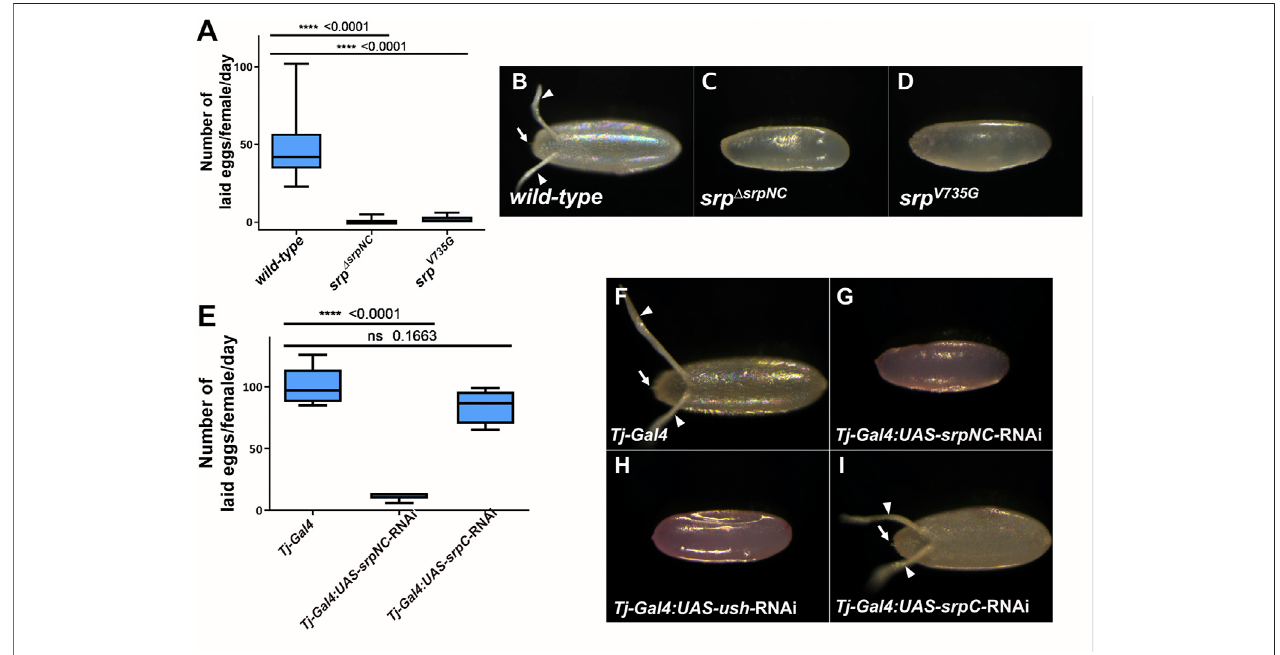
FIGURE6| SrpNC/Ush interaction, butnotSrpC,isessentialforfemalefertility.Box-whiskerplotsshowingthenumber (A,E) ,andmorphology (B – D,F – I) ,ofeggs laid by wild-type, srp Δ srpNC , srp V735G females (A) and fl ies having srpNC and srpC downregulated by RNAi in the ovarian follicle cells using the Traf fi c Jam ( Tj ) driver ( Tj- Gal4 ) (E) ,at daythreeaftermating. srp Δ srpNC and srp V735G fl ies producefew (A) defective (C,D) eggs.RNAidownregulationof srpC (E) infemale fl ies using Tj-Gal4 does not affect their fertility (I) contrary to female knock-down in srpNC (G) or ush (H) whose progenies show morphological defects. Unpaired t -test was used to compare wild-type (A) or background control (E) to the indicated